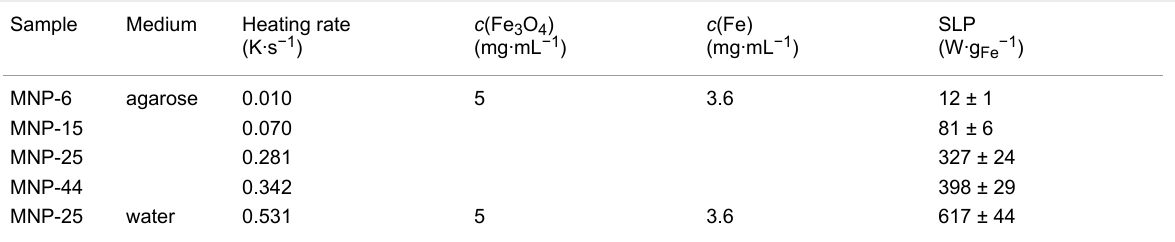
Table 4: The heating rate Δ T / Δ t and calculated SLP values for various NP concentrations and sizes in agarose and aqueous medium using MNP-25 as a reference.